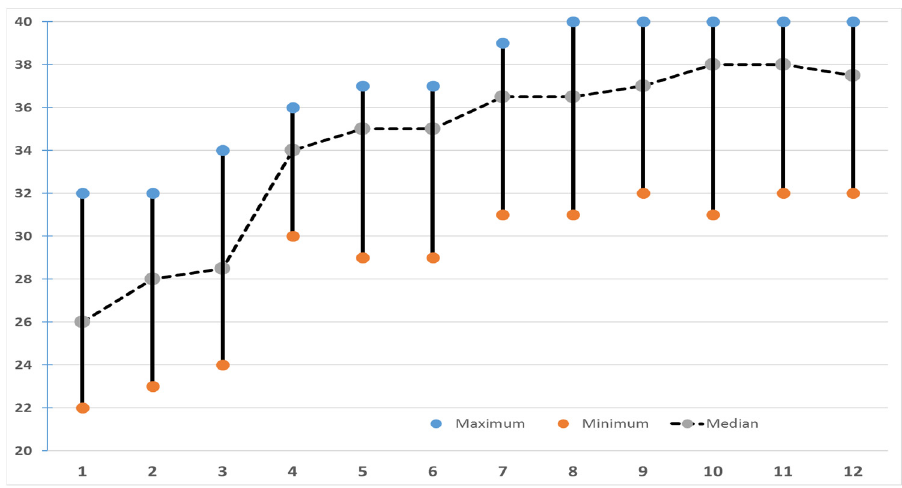
Figure 1. The median, maximum and minimum self-esteem scores for the group of mentors over the 12 months of training ( n = 14).